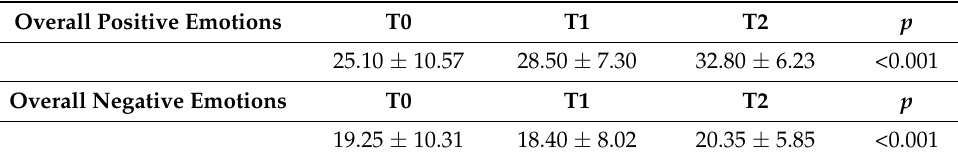
Table 4. Means and standard deviations of the overall positive and negative emotion scores in different times of administration.